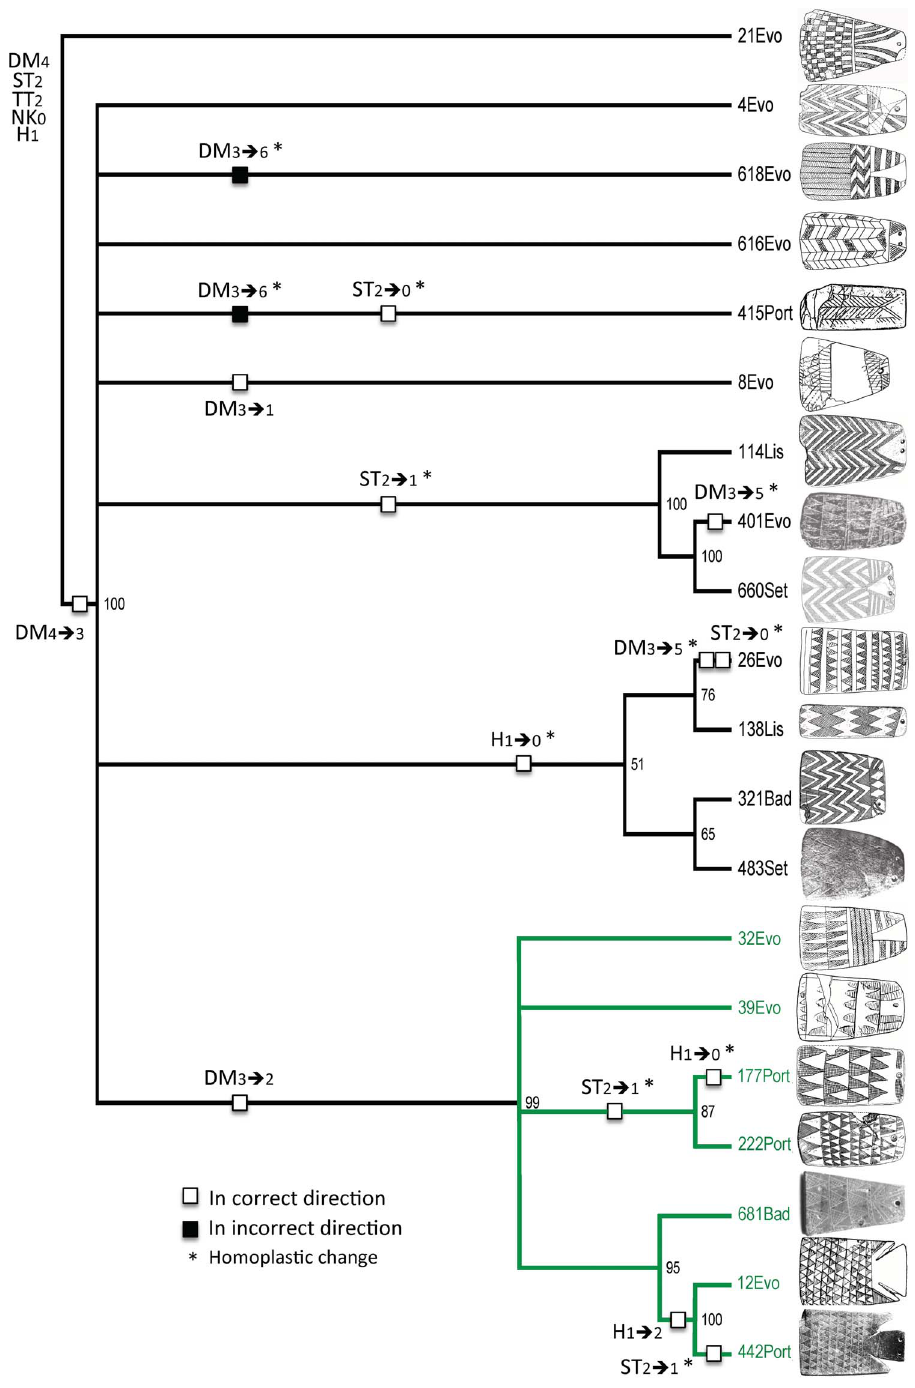
Figure 9. Fifty-percent majority-rule consensus tree from exercise 4, sample 2 (the 4/2 tree) showing character-state changes states according to the assumed polarities for characters DM, ST, and H. Changes of states for characters TT and NK do not appear here because Lillios’s hypothesis makes no assumptions about polarity. Numbers at nodes are bootstrap values.